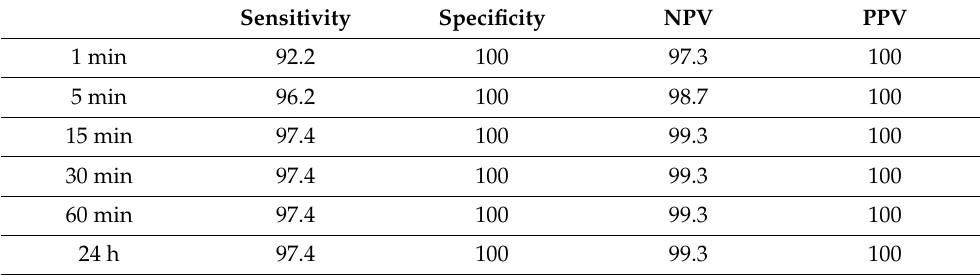
Table 3. Sensitivity, specificity, negative predictive value (NPV) and positive predictive value (PPV) of the iNatal duo test in patients not taking PPI.